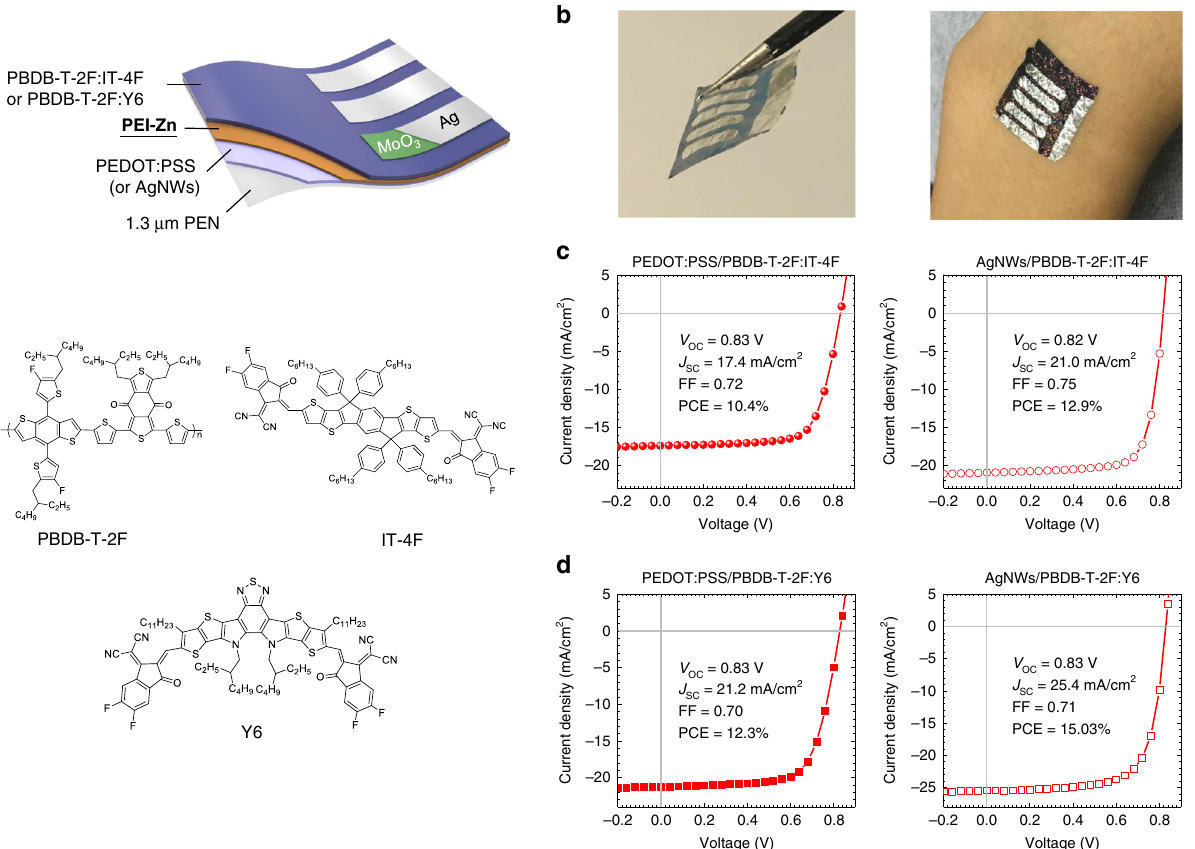
Fig. 1 Device structure and photovoltaic performance of the ultra fl exible OSC. a Device structure of the ultrathin solar cells and chemical structure of the nonfullerene active layer; A Zn 2 + -chelated polyethylenimine (PEI-Zn) is developed as the electron-transporting layer (ETL). b Pictures of the fabricated ultrathin OSCs; the picture on the right is a cell attached on the wrist. c , d J - V characteristics of the ultrathin devices with conducting polymer (PEDOT:PSS) or Ag nanowires as the transparent electrodes. Two different nonfullerene active layers of PBDB-T-2F:IT-4F and PBDB-T-2F:Y6 were used in the ultra fl exible